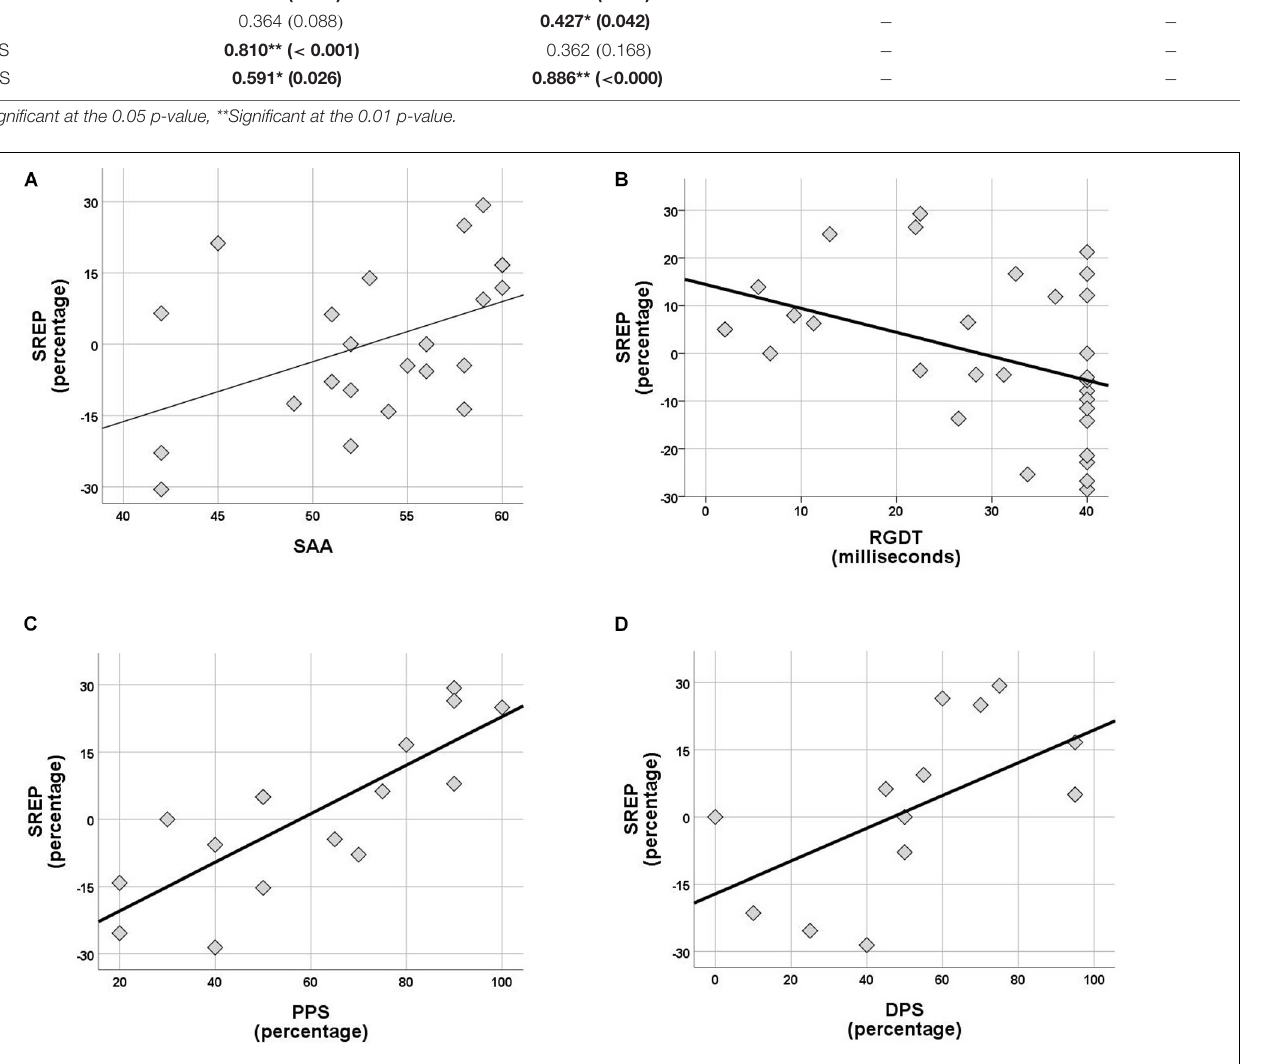
FIGURE 4 | (A–D) Scatterplots of SREP scores vs. SAA, RGDT, PPS, and DPS respectively, for the APD group. Correlations are r = 0.464, p = 0.026, r = –0.417, p = 0.020, r = 0.810, p < 0.001 and r = 0.591, p = 0.026. SREP, synchronized rhythm effect percentage; SAA, sustained auditory attention; PPS, pitch pattern sequence; DPS, duration pattern